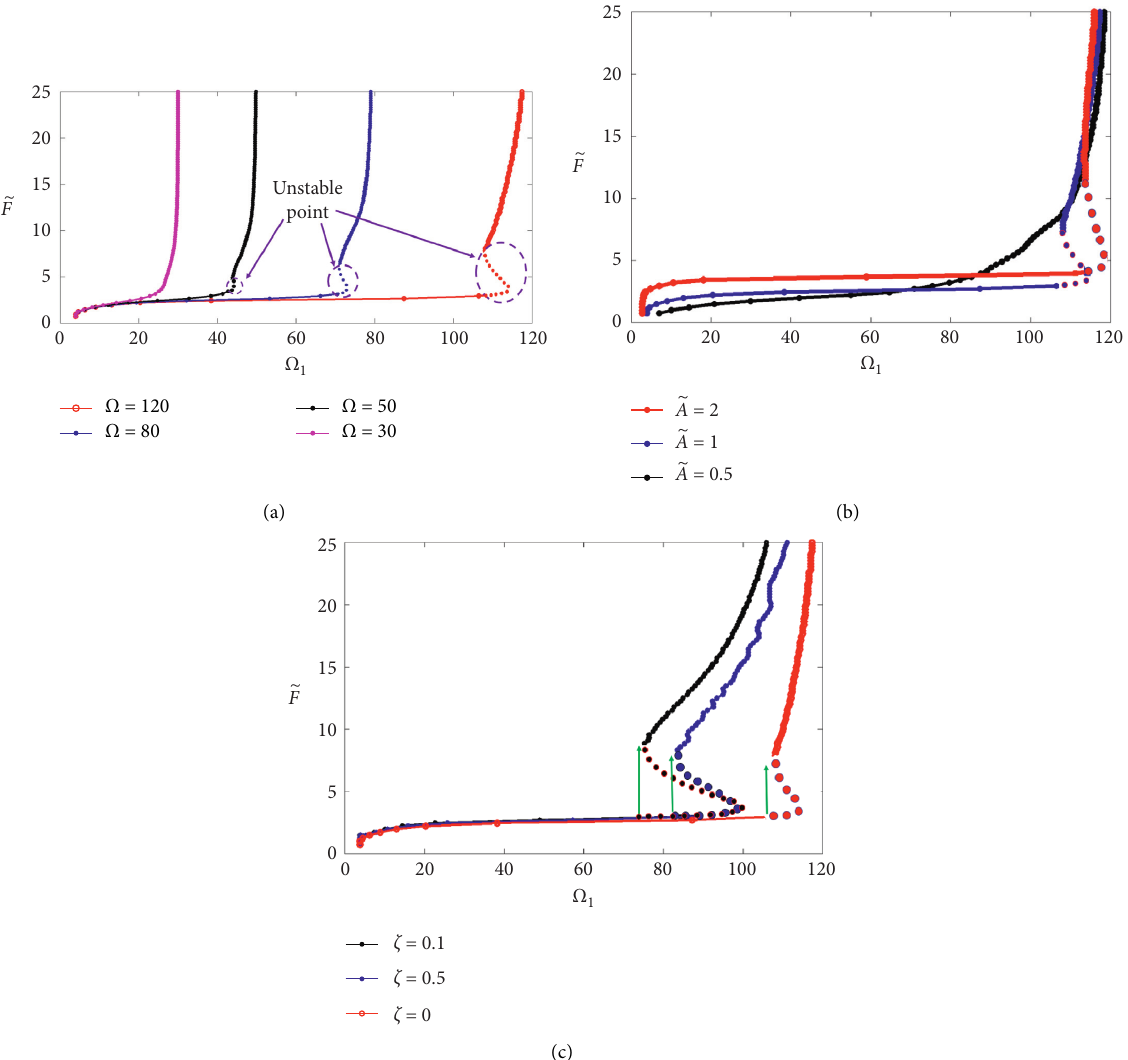
Figure 11: The time-domain response of the NSA ( 􏽥 A � 1, w � 200 π /s, μ � 6 . 7 × 10 − 4 ζ � 0). (a) Shock acceleration response under different % F , Ω � 120. (b) Shock displacement response under different % F , Ω � 120. (c) Shock acceleration response under different % F , Ω � 30, ζ � 0. (d) Shock displacement response under different % F , Ω � 30. (e) Shock acceleration response when % F � 3 . 65 and % F � 13, Ω � 120. (f) Shock displacement response when % F � 3 . 65 and % F � 13, Ω �